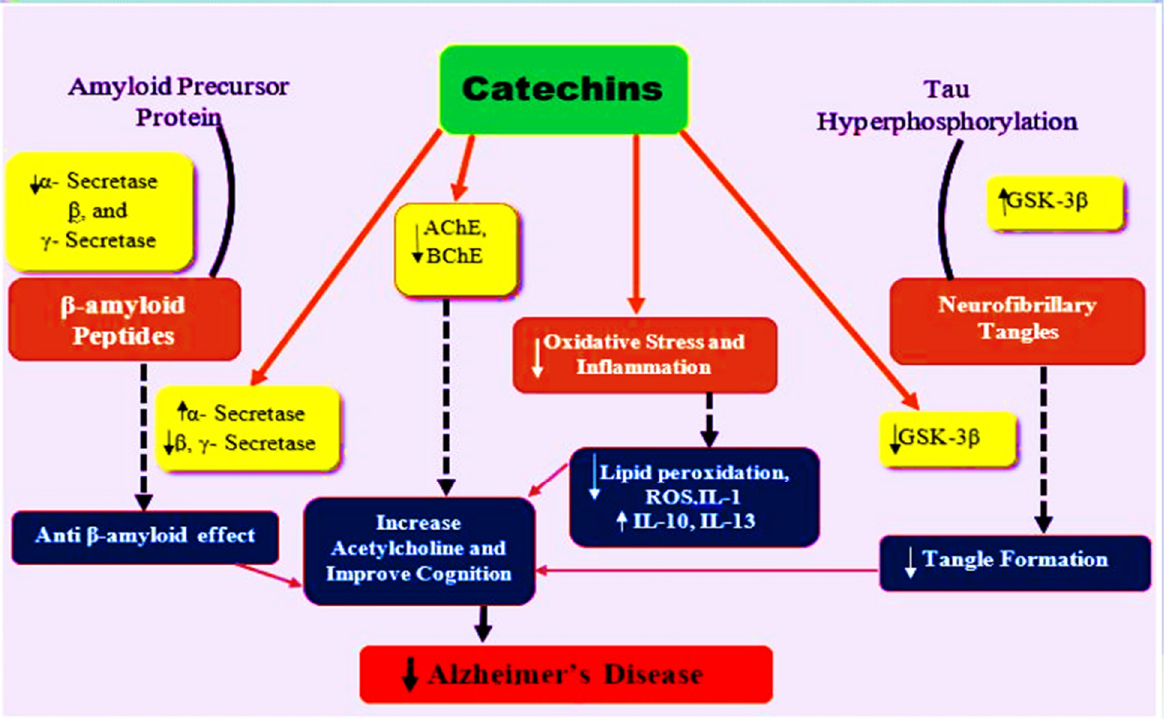
Figure 4. The neuroprotective mechanism of catechins in Alzheimer’s disease. Α , β , and γ -secretase produce β -amyloid from amyloid precursor proteins, while GSK-3 β catalyzes tau hyperphosphorylation that leads to neurofibrillary tangles, which ultimately results in oxidative stress and inflammation. The catechins inhibit β , γ -secretase, and GSK-3 β activity, thereby preventing amyloid plaques and neurofibrillary tangles formation, as well as possessing anti-inflammatory and anti-oxidative properties and increasing acetylcholine levels in the synaptic cleft, thereby improving the decline in cognitive function in AD.